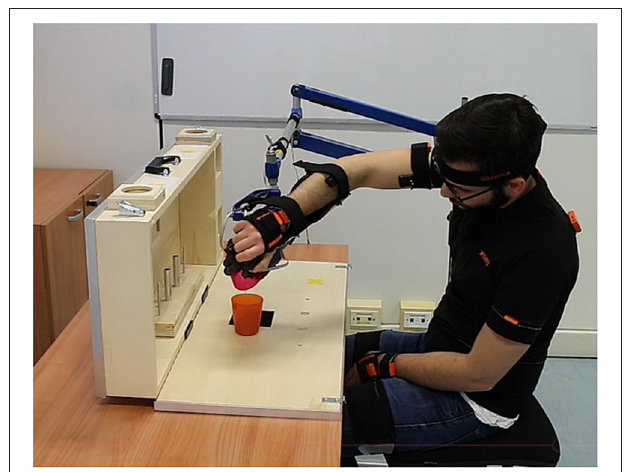
FIGURE 1 | Example of head and trunk compensatory movements performed by a subject during the execution of a task of the ARAT test (pouring task).